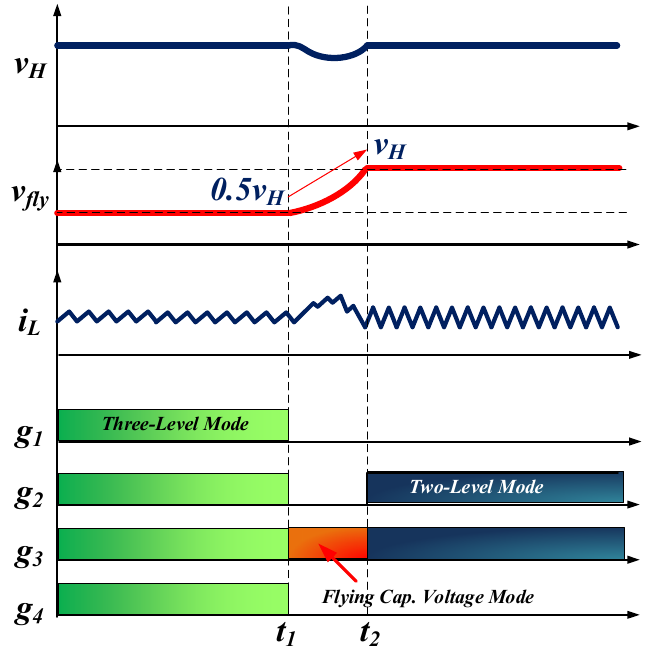
Figure 7. The diagram of the key quantity under the situation in which short-circuit fault occurs in switch S 4.